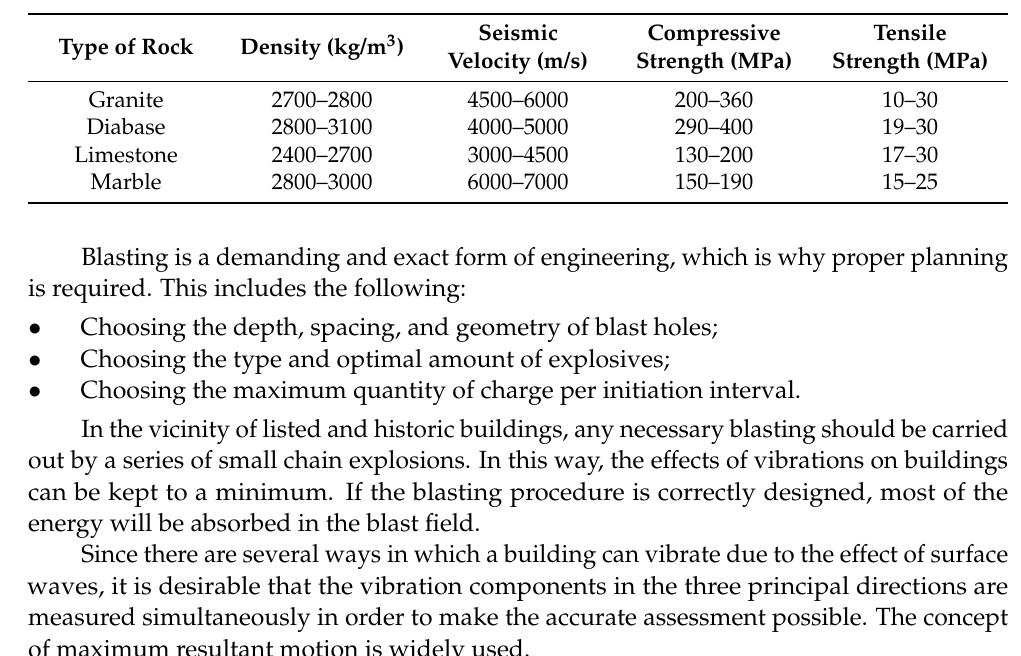
Table 1. Rock characteristics influencing